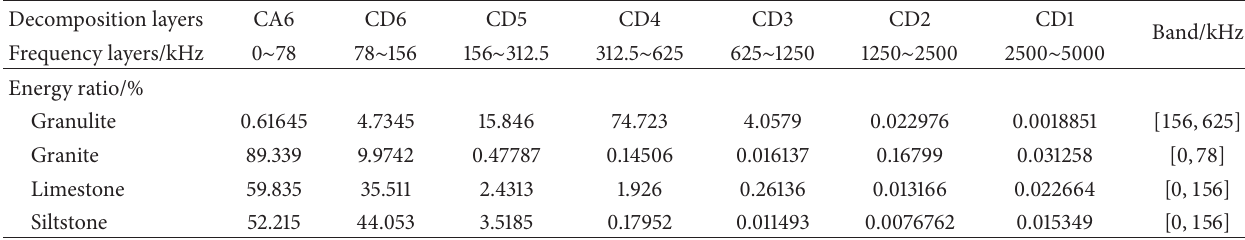
Table 1: Energy ratio of the wavelet transformed AE signals in